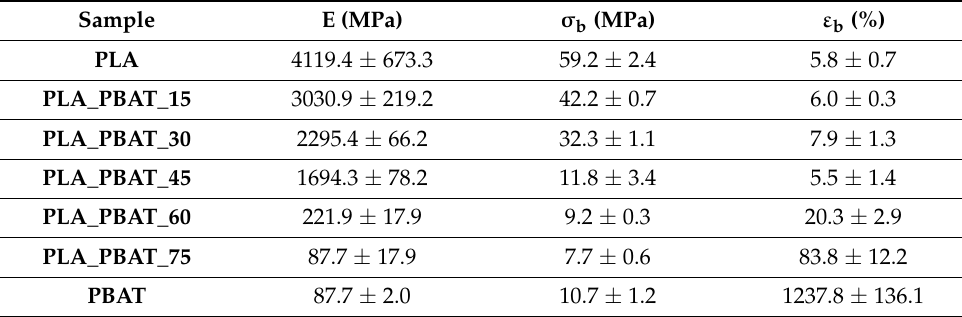
Table 5. Result of quasi-static tensile test at 25 ◦ C on the prepared samples.